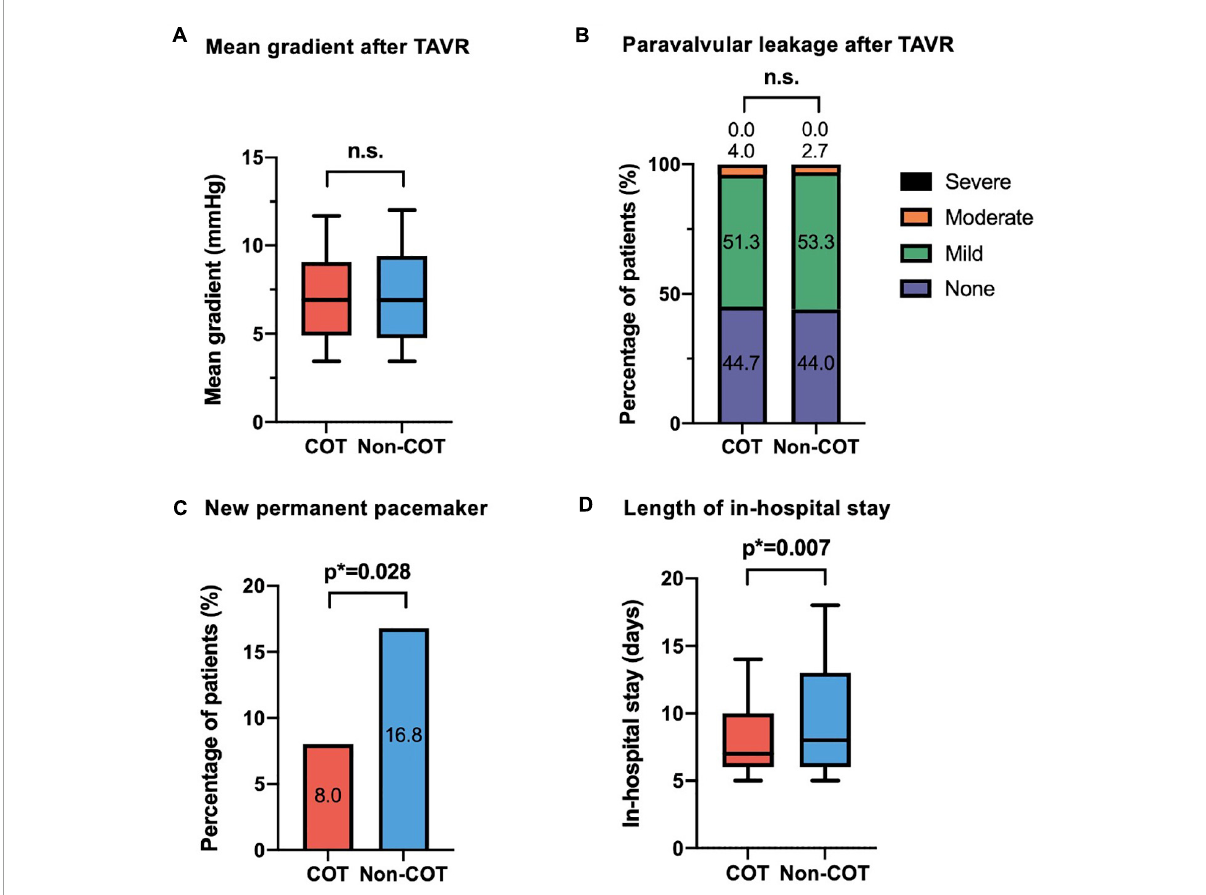
FIGURE5 Efficacy outcome of COT. No difference could be observed in (A) mean aortic gradient and (B) paravalvular leakage following TAVR with different deployment techniques. In the COT group, fewer new permanent pacemaker implantations during 30-day follow-up were needed (COT 8.0% vs. Non-COT 16.8%; p = 0.028) (C) , and a reduced length of in-hospital stay could be achieved (COT 8.4 ± 4.0 vs. Non-COT 10.3 ± 6.7 days; p = 0.007) (D) . COT, cusp-overlap technique; TAVR, transcatheter aortic valve